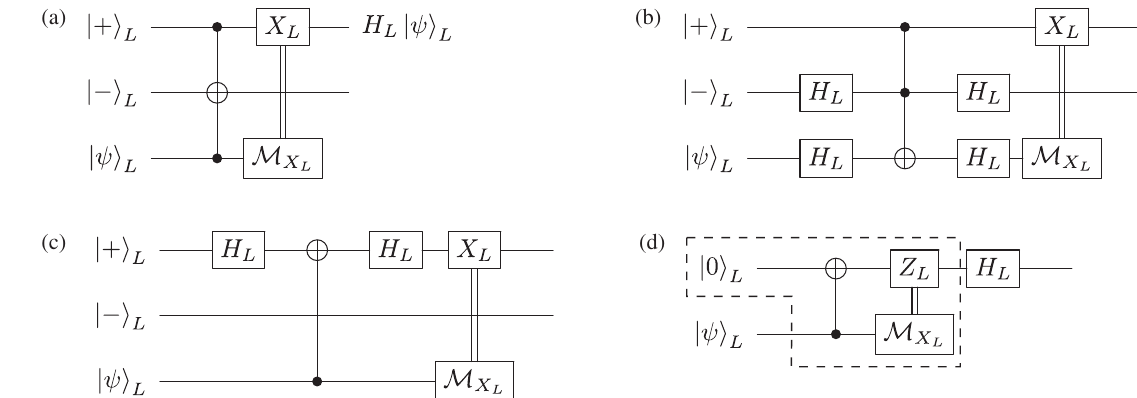
FIG. 9. Logical Hadamard circuit (a). The circuits (b) – (d) are equivalent circuits that help to understand why the circuit (a) implements a logical Hadamard gate. In circuit (b), the CNOT gate between the repetition cat qubits 2 and 3 is replaced by the equivalent circuit where the control and target roles are switched with the addition of Hadamard gates before and after the gate. It becomes clear in circuit (b) that the second repetition cat qubit plays no role: It is initialized in j − i , transformed to j 1 i after the first Hadamard, and, thus, always L L triggers the corresponding part of the control of the Toffoli, before being converted to j − i by the second Hadamard. Actually, the L second repetition cat qubit is needed only because we do not readily have a controlled-phase gate available at the repetition cat qubit level (but here we show that it can be done with the Toffoli gate plus one ancilla repetition cat qubit). The idle role of the second repetition cat qubit is represented more simply in circuit (c), where again the CNOT between the repetition cat qubits 1 and 3 is replaced by its equivalent circuit where the control and target roles are exchanged with the addition of Hadamard gates. Finally, in circuit (d) (where we omit the second repetition cat qubit for clarity), the first Hadamard of the first line and the preparation of jþi are replaced L by the equivalent preparation of j 0 i and the second Hadamard is commuted through the X , producing a Z gate. The remaining circuit L L L in the dashed box is just a teleportation of the state j ψ i of the second repetition cat qubit to the first one. After the state is teleported, the L remaining Hadamard gate H is applied, thus establishing the equivalence between circuit (a) and a logical L